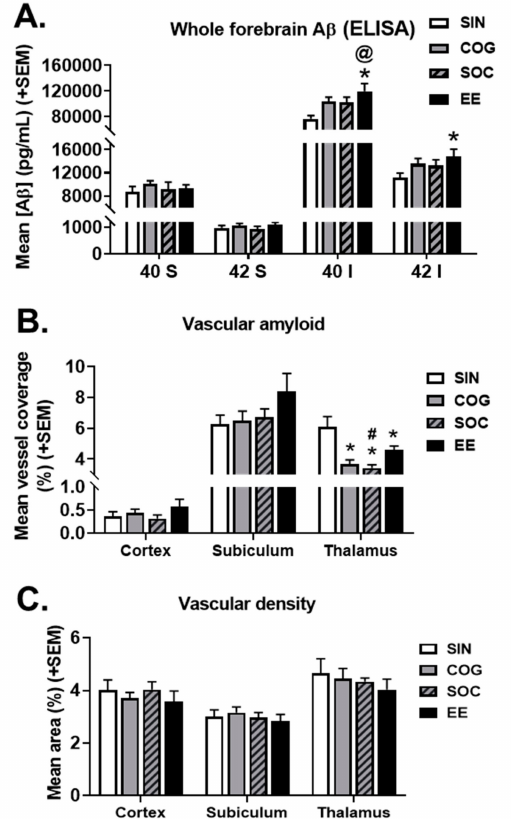
Figure 6. E ff ects of the housing condition on the accumulation of A β in Tg-SwDI mice. ( A ) Tg-SwDI mice housed in EE conditions had increased insoluble A β 40 and A β 42) levels, as measured by ELISA of whole forebrain homogenates. ( B ) Tg-SwDI mice in all enrichment conditions had less vascular amyloid in the thalamus compared to single-housed mice. ( C ) The housing condition did not a ff ect the cerebral vascular density in any of the three brain regions measured. * p < 0.05 vs. SIN of the same genotype, @ p < 0.05 vs. COG of the same genotype, # p < 0.05 vs. EE of the same